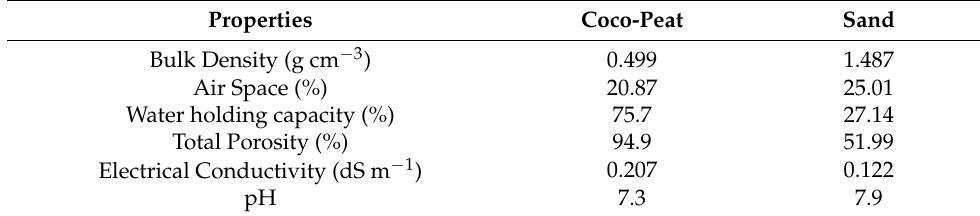
Table 2. Some physicochemical characteristics of